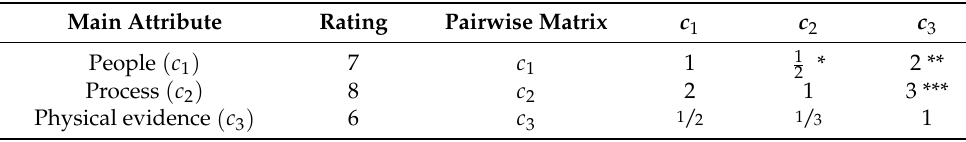
Table 2. Conversion of preference ratings into a pairwise matrix. Main Attribute Rating Pairwise Matrix